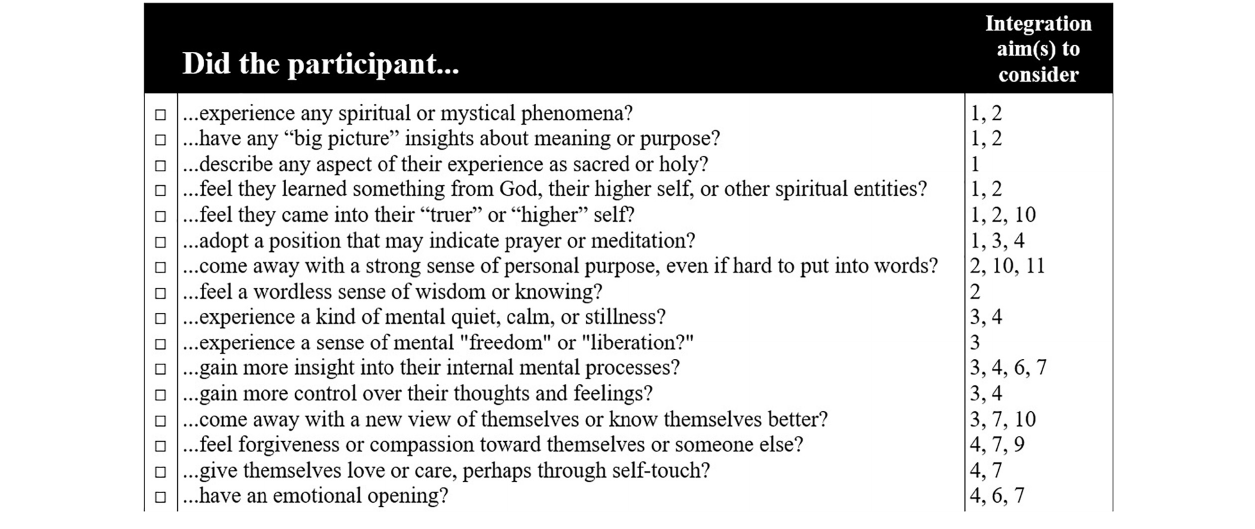
FIGURE 3 | Portion of integration aim guidance checklist provided in EMBARK manual for MDD treatment. Numbers in the “Integration aim(s) to consider” column refer to suggested integration aims detailed in the rightmost column of Figure 1